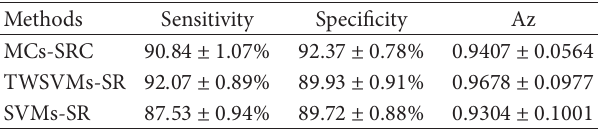
Table 1: Experimental results of the proposed MCs-SRC method for MCs detection, compared with sparse representation based TWSVMs and SVMs